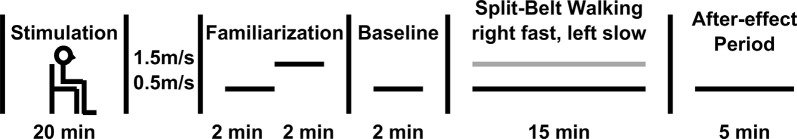
Experimental paradigm. Stimulation occurred before the gait adaptation paradigm. Gait parameters were recorded during the baseline, split-belt walking, and after-effect periods.